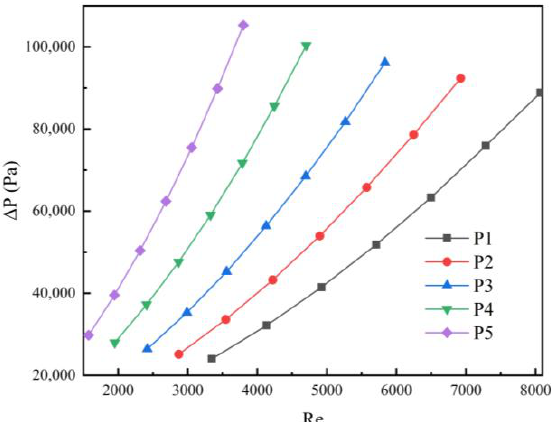
Figure 21. Distributions of pressure drop versus different Reynolds numbers and Prandtl numbers.